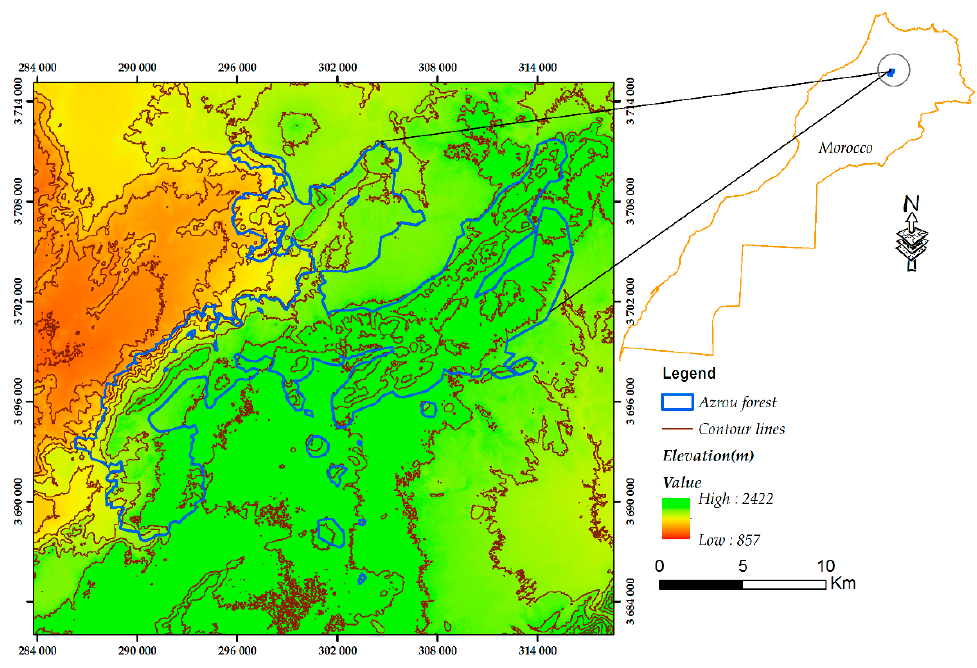
Figure 1. Location of the study area (elevation data) .